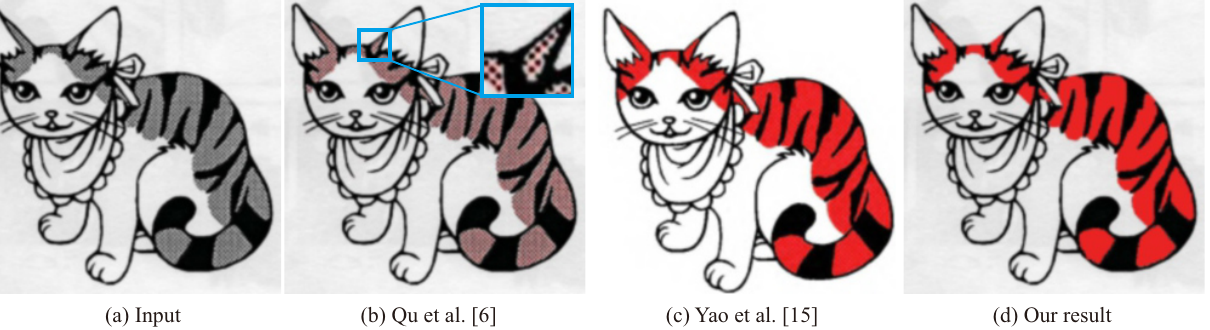
Fig. 9 ‘Cat’ (956 × 943, loading time: 3.60s, processing time: 3.86s).